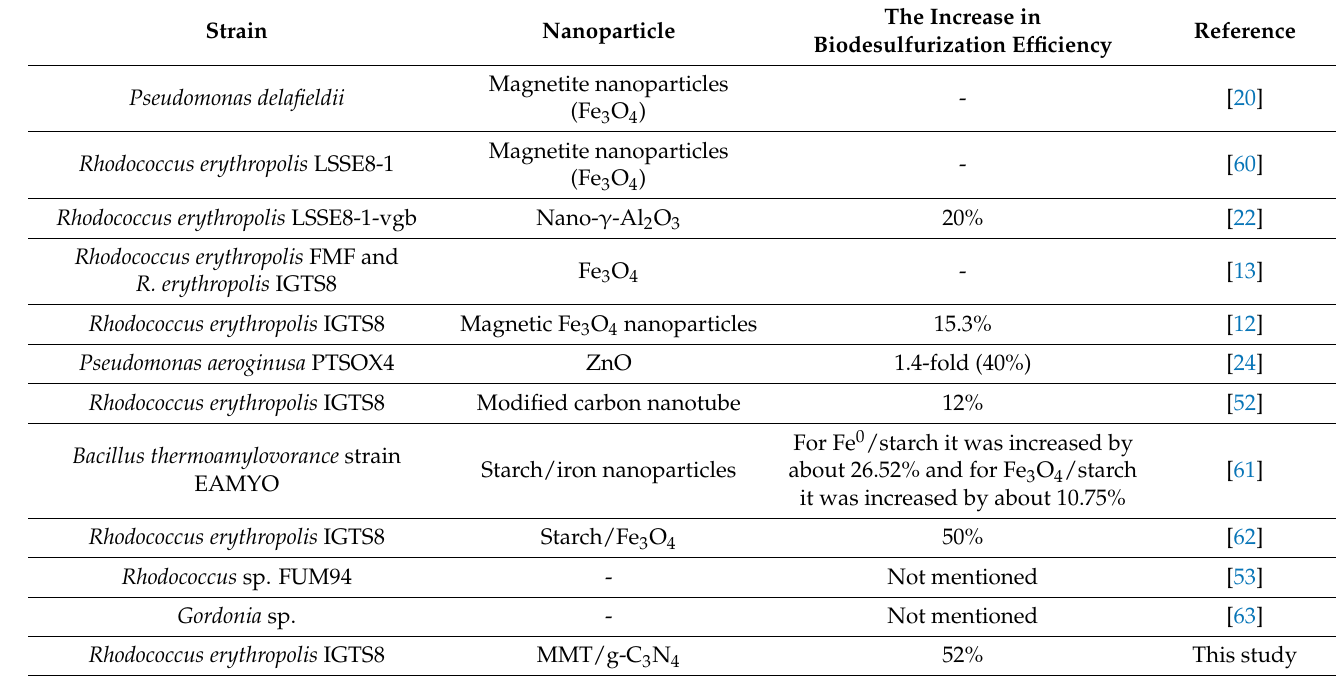
Table 7. Comparison of the results of research in the field of